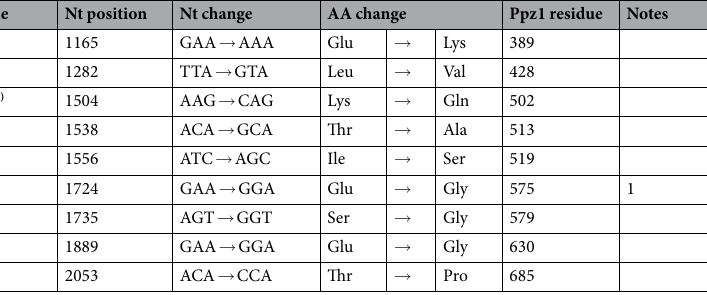
Table 1. Mutations affecting the catalytic domain of Ppz1 that result in single amino acid change. (a) Same than clone 126. (b) Same than clone 141. (1) Mutation also found in clones 139 and 143 (these clones carry an additional mutation at nt 1296 that do not change amino